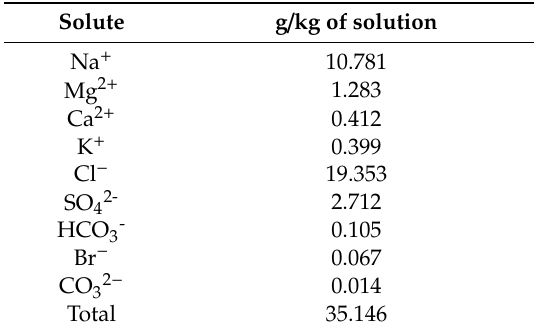
Table 4. Reference composition of seawater, with principal ions (Modified from Cisternas and G á lvez, [45]).